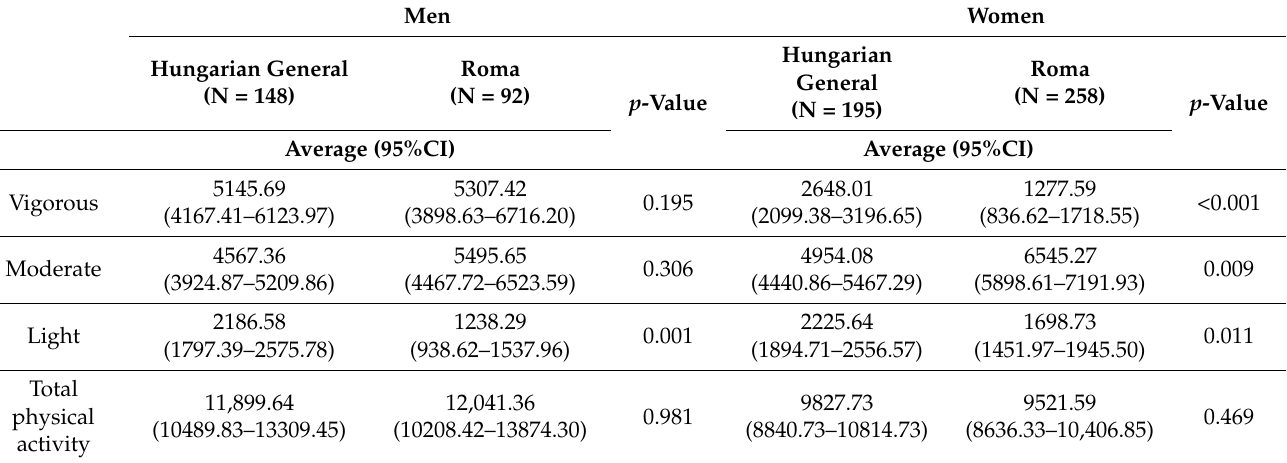
Table 2. Physical activity expressed in average METs per week by intensity categories among men and women in the Hungarian general and Roma populations. Men